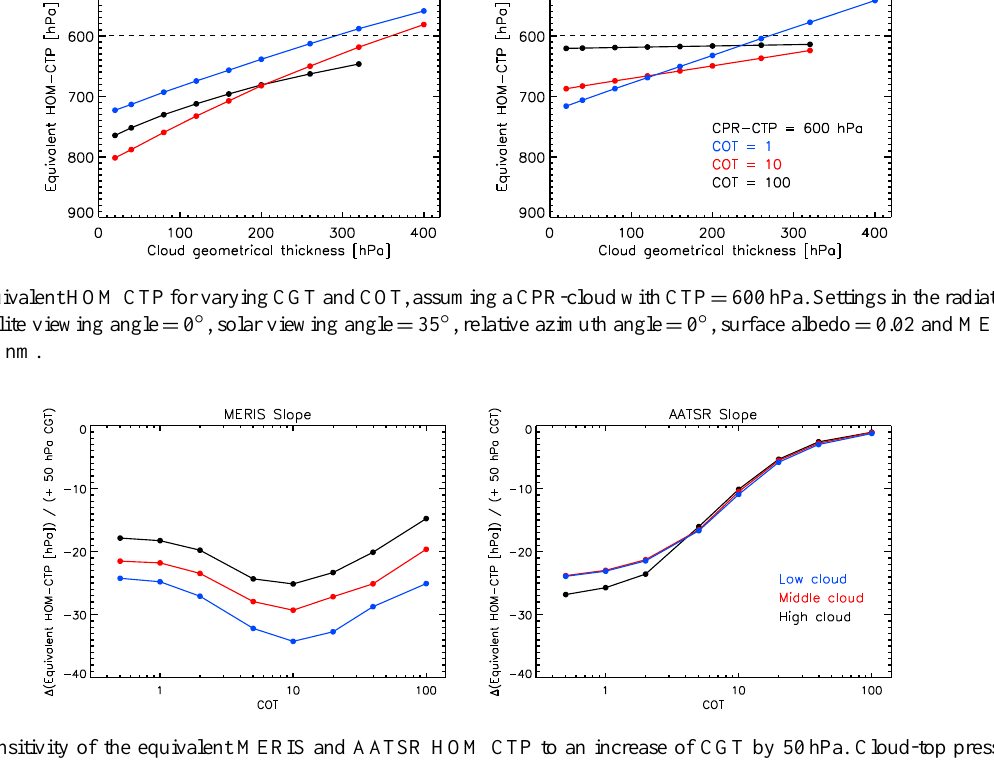
Figure 3. The sensitivity of the equivalent MERIS and AATSR HOM CTP to an increase of CGT by 50hPa. Cloud-top pressure of low cloud = 800hPa, middle cloud = 600hPa, and high cloud =